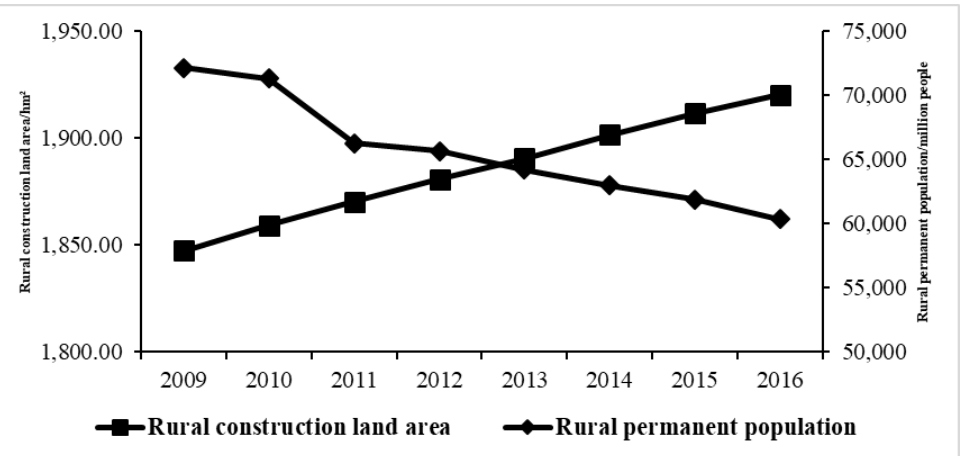
Figure 1. Change trend of the number of the rural permanent population and rural construction land areas from 2009 to 2016.